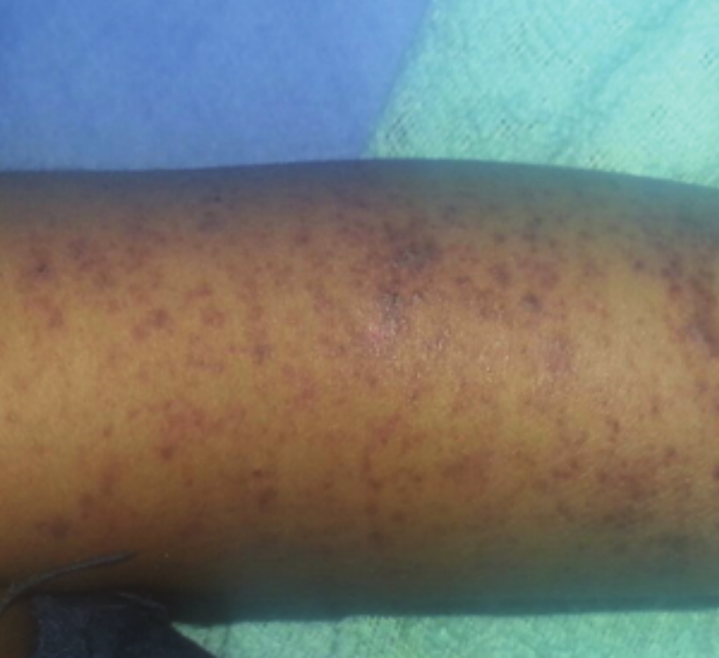
Figure 1: Extensive